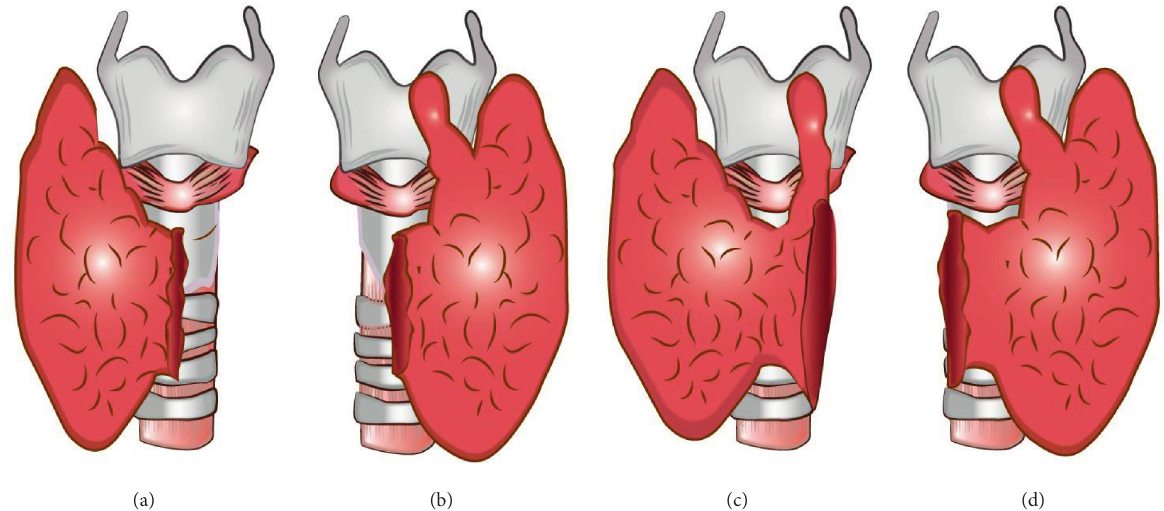
Figure 2: Illustrations of the preserved portions of the thyroid gland following conventional thyroid lobectomy and pyramid- and isthmus- preserving lobectomy (PIPL). (a) Left conventional thyroid lobectomy. (b) Right conventional thyroid lobectomy. (c) Left PIPL. (d) Right PIPL.